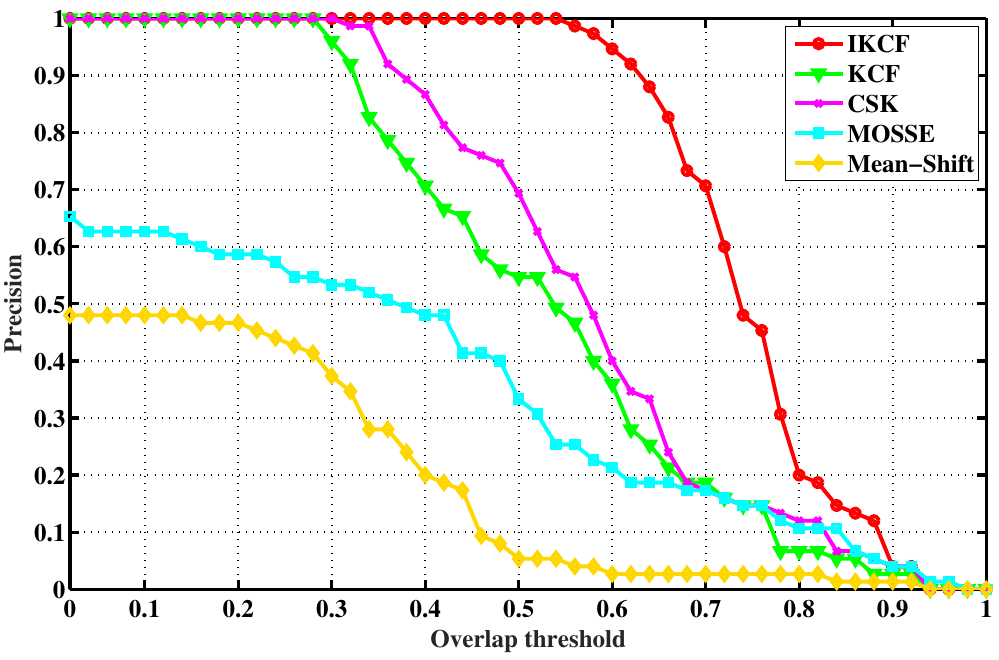
Figure 11. Overlap precision curves (1082nd frame to 1152nd